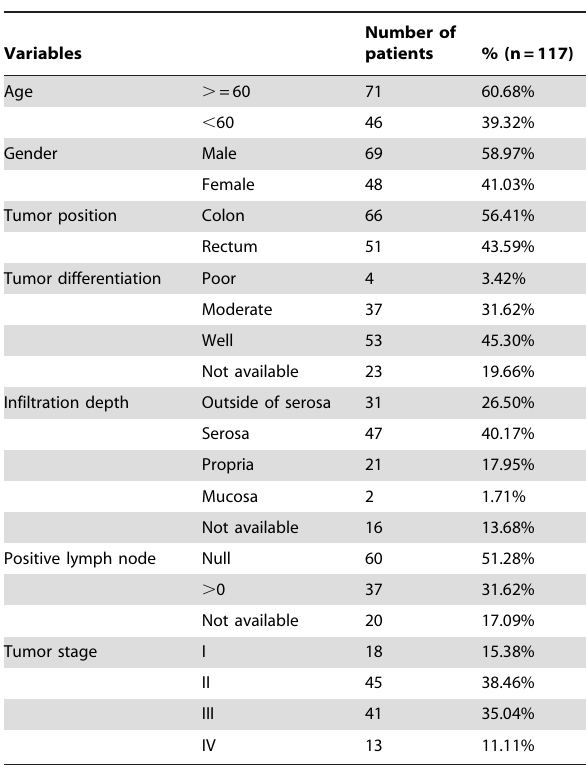
Table 8. The clinicopathological characteristics of 117 Chinese CRC